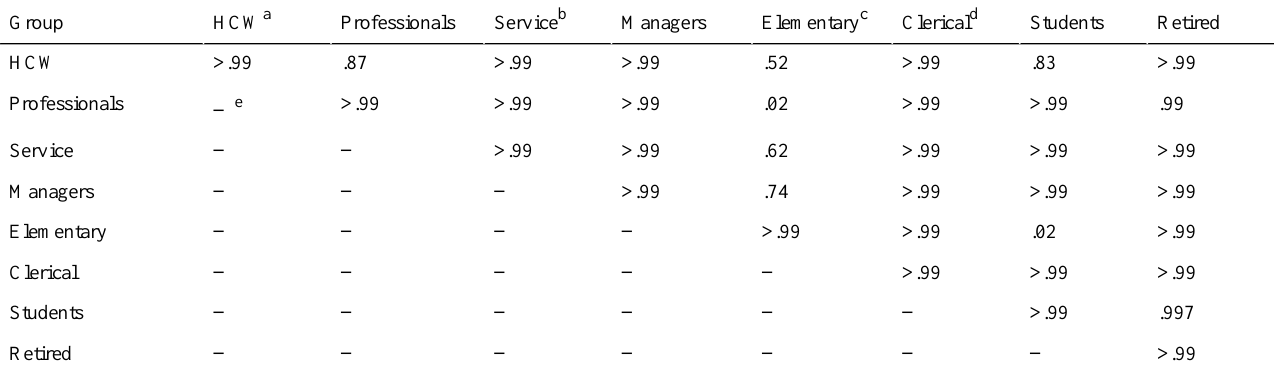
Table 6. Post hoc comparisons ( P values) among Kmean values of occupation subgroups using Hochberg GT2